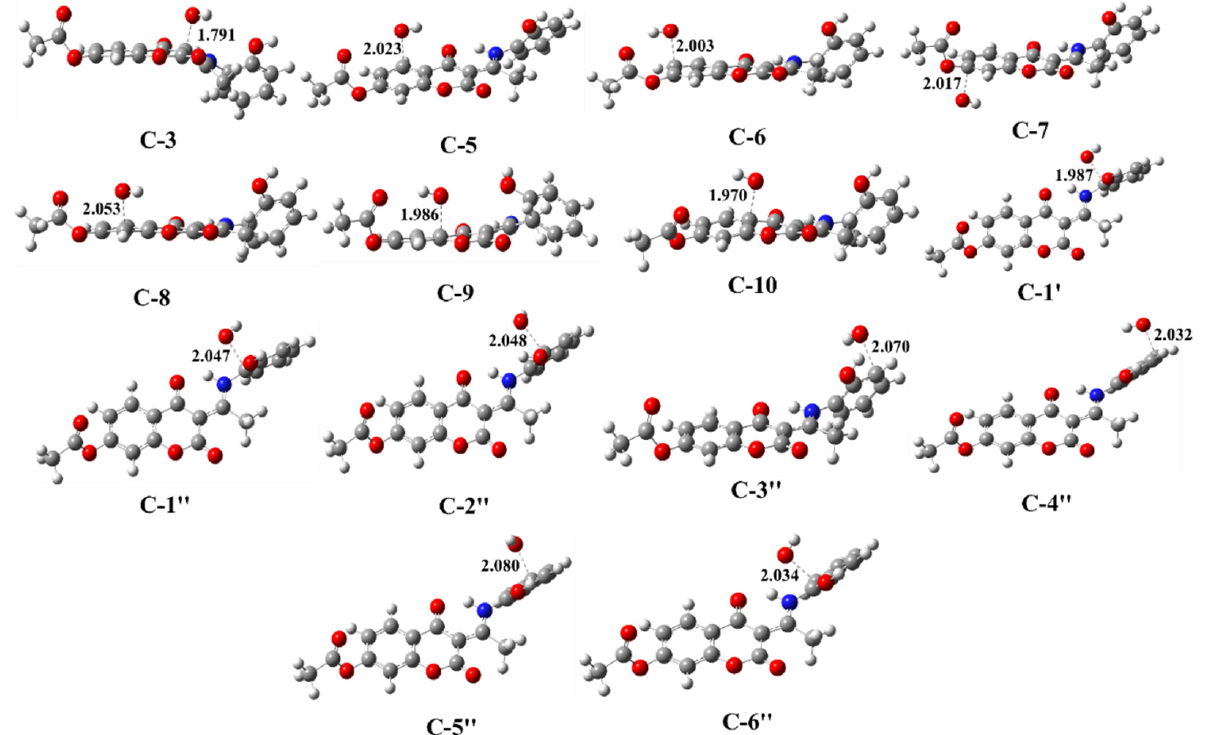
Figure 6. Optimized transition state geometries for radical adduct formation for A 2 –RH and HO • in water at M06-2X/6 − 311++G(d,p) level of theory.